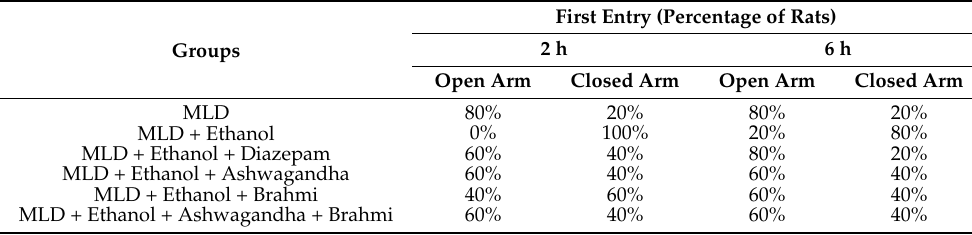
Table 2. Elevated plus maze first entry in different groups at 2nd and 6th hour of alcohol withdrawal.